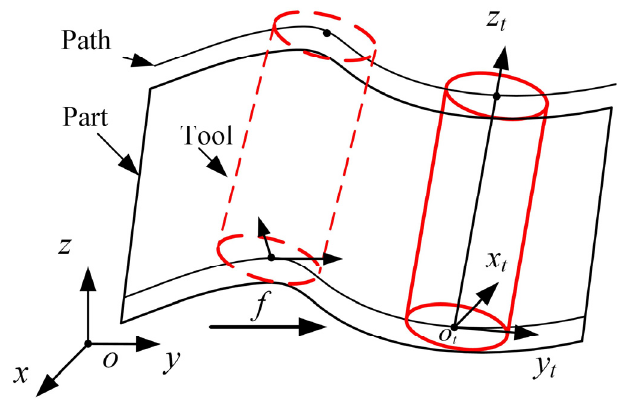
Figure 3. Five-axis flank machining.